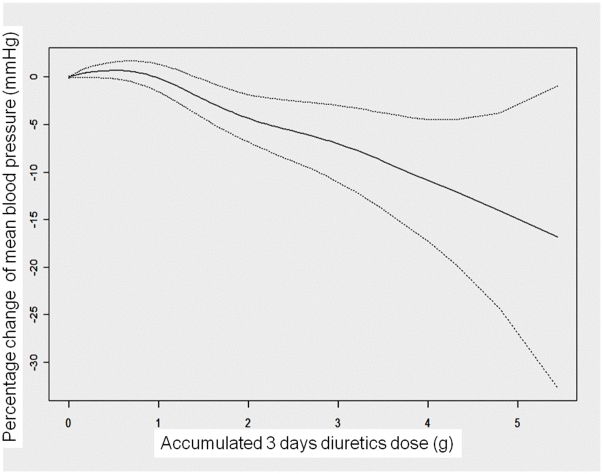
Accumulated diuretics related to blood pressure.The smoothed plot of a generalized additive model for the relationship between time-varying three-day accumulative diuretic dose and blood pressure difference in post-surgical dialysis patients with adjustments for possible linear and nonlinear effects* (p<0.001).